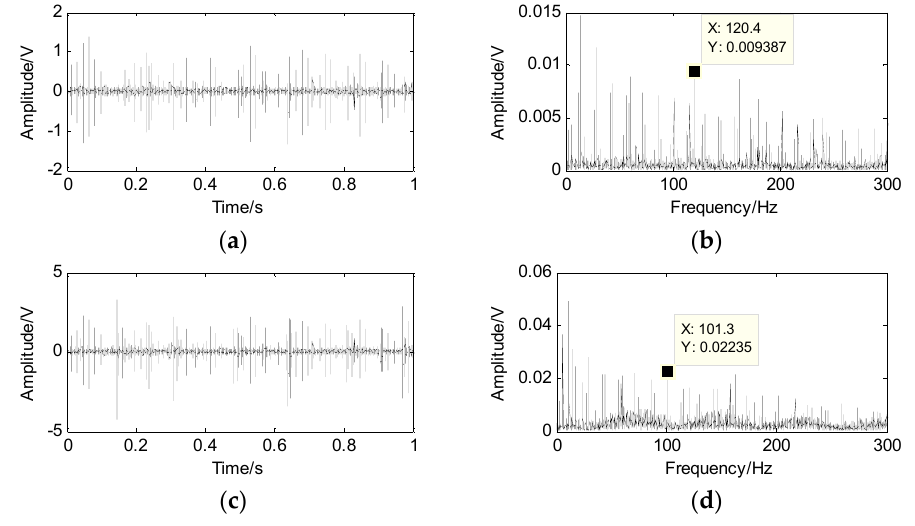
Figure 14. The separated source signal and its spectrum by traditional SCA method. ( a ) the first separation of signal; ( b ) spectrum of the first separation signal; ( c ) the second separation of signal; ( d ) the spectrum of second separation signal.